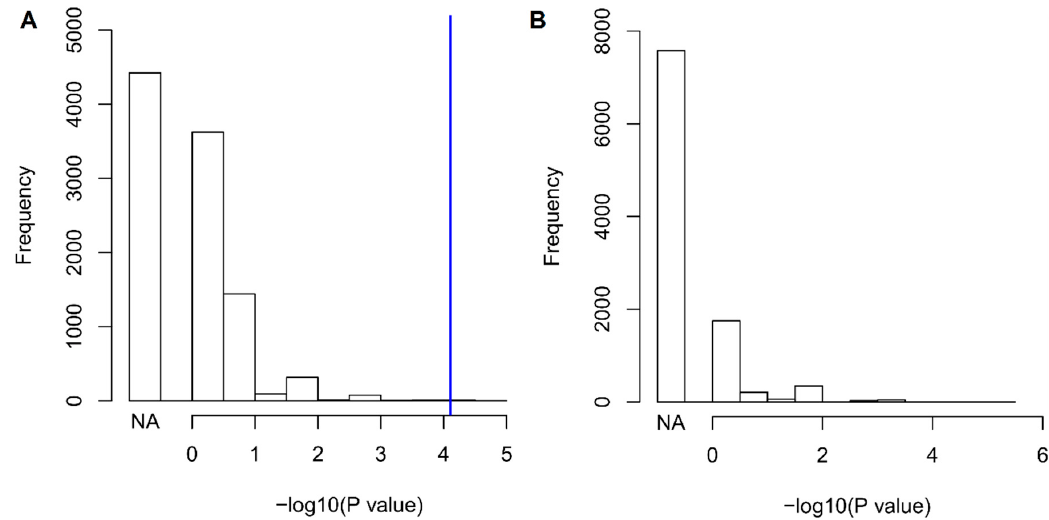
Figure 2. Null distribution of association results generated through 10,000 random permutations of having 10 or more outpatient surgeries with respect to Val122Ile genotype status in the whole cohort ( A ) and in the male-only sample ( B ). Blue lines indicate the observed values. The “NA” column represents the permutation results where no case is a carrier of the Val122Ile mutation.